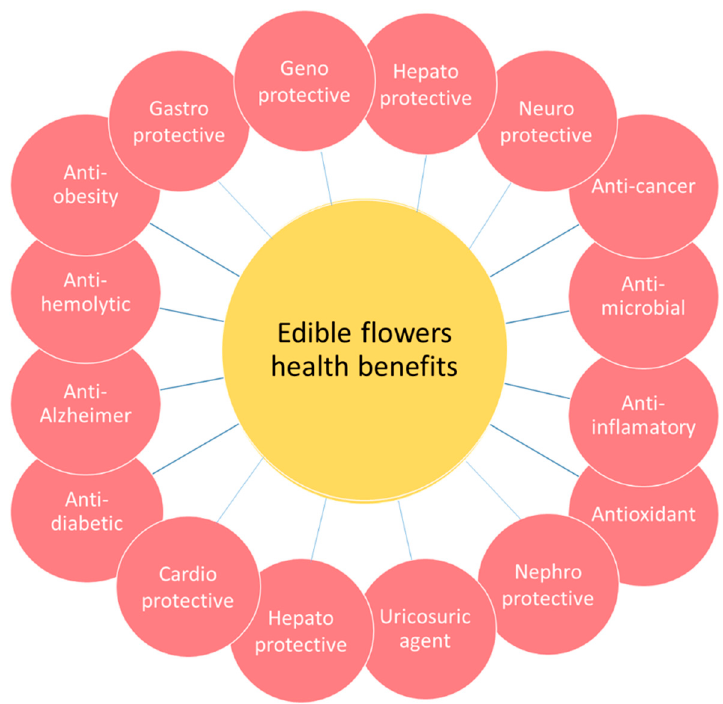
Figure 2. Potential health benefits linked with edible flowers.